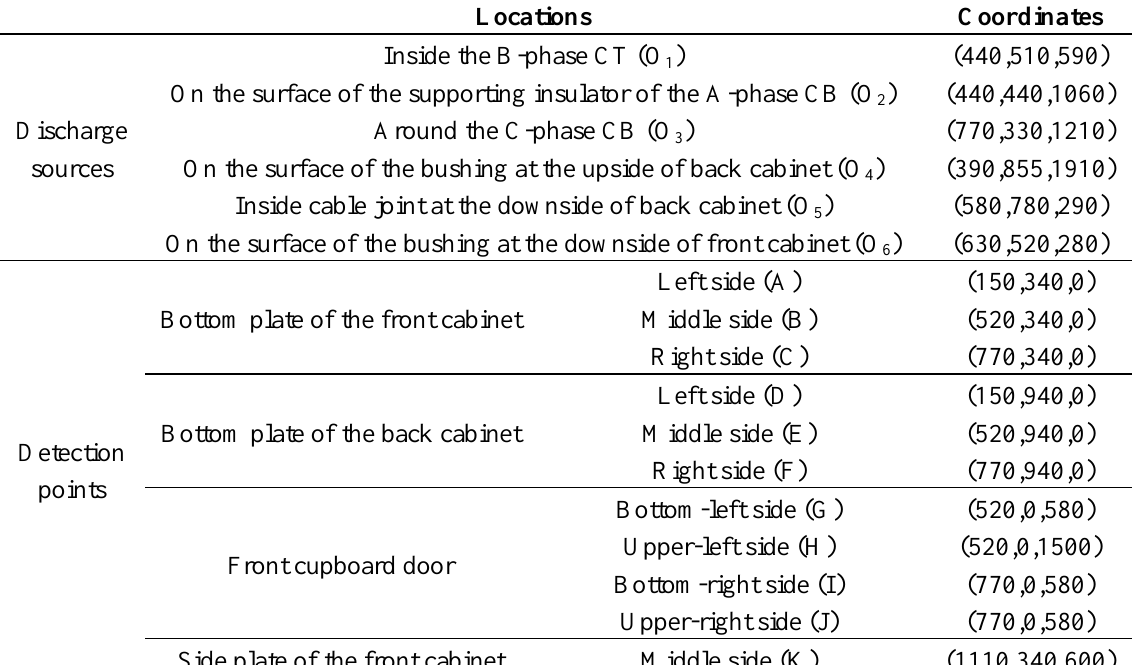
Table 4. Coordinates of discharge sources and detection